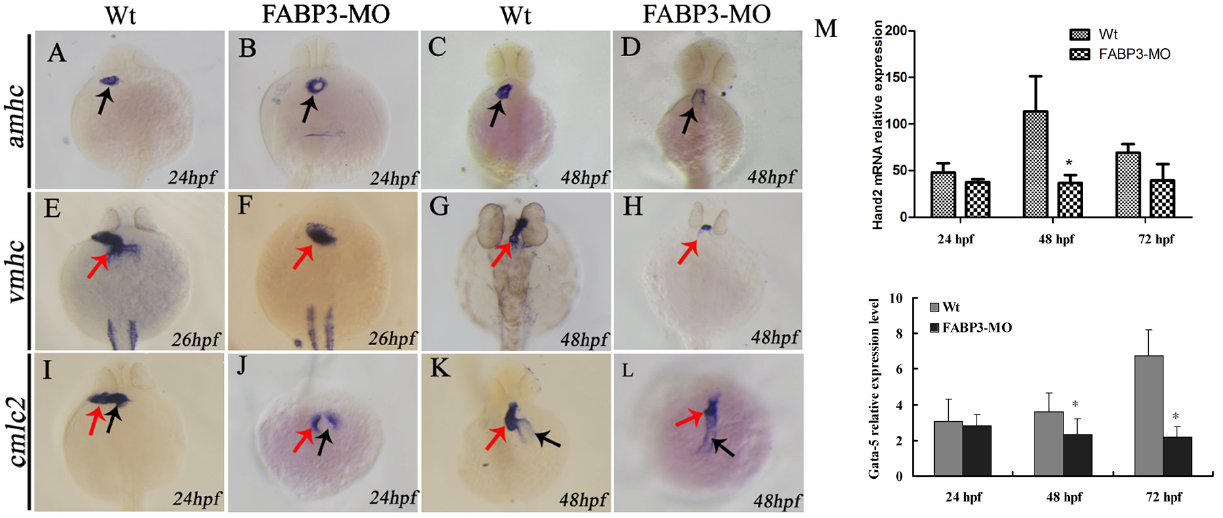
Figure 4. Effect of FABP3-MO on the expression of cardiac-specific genes in zebrafish. Cardiac-specific markers amhc (24 and 48 hpf), vmhc (26 and 48 hpf) and cmlc2 (24 and 48 hpf) were used to observe cardiac morphology within the whole embryo using in situ hybridization (red arrows), and the expression of Hand2 was assayed by real-time PCR at 24, 48 and 72 hpf, respectively. Compared to Wt-MO ( A ), amhc expression was abnormally positioned ( B ) at 24 hpf, and was significantly downregulated in FABP3-MO injected embryos at 48 hpf ( D ), as compared to control embryos ( C ). Vmhc expression was also in an abnormal position and appeared lower in FABP3-MO treated embryos at 24 hpf ( F ) and 48 hpf ( H ), compared to control embryos at 24 hpf ( E ) and 48 hpf ( G ), respectively. Cmcl2 expression revealed that heart looping was incomplete and formed a liner cardiac tube in FABP3-MO injected embryos ( K ), compared to the normally looped heart in control embryos ( K ). Hand2 and Gata5 expression is downregulated in zebrafish induced by FABP3-MO compared to Wt-MO at the three time points examined ( M ). * p <